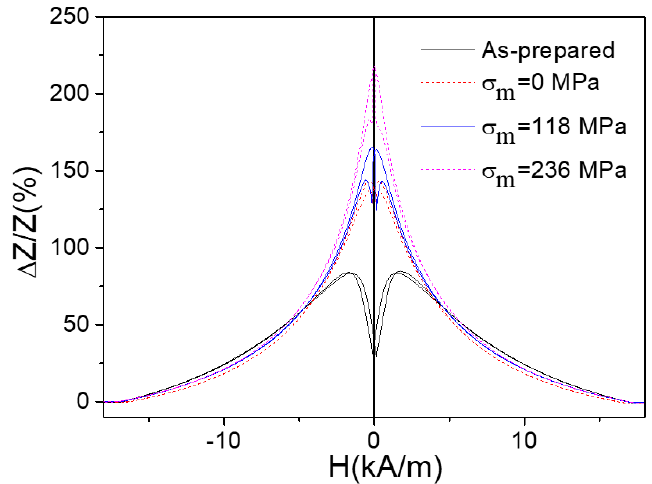
Figure 9. Dependencies of GMI ratio on different value of the external tension stress measured at 200 MHz. Reprinted with permission from [5].